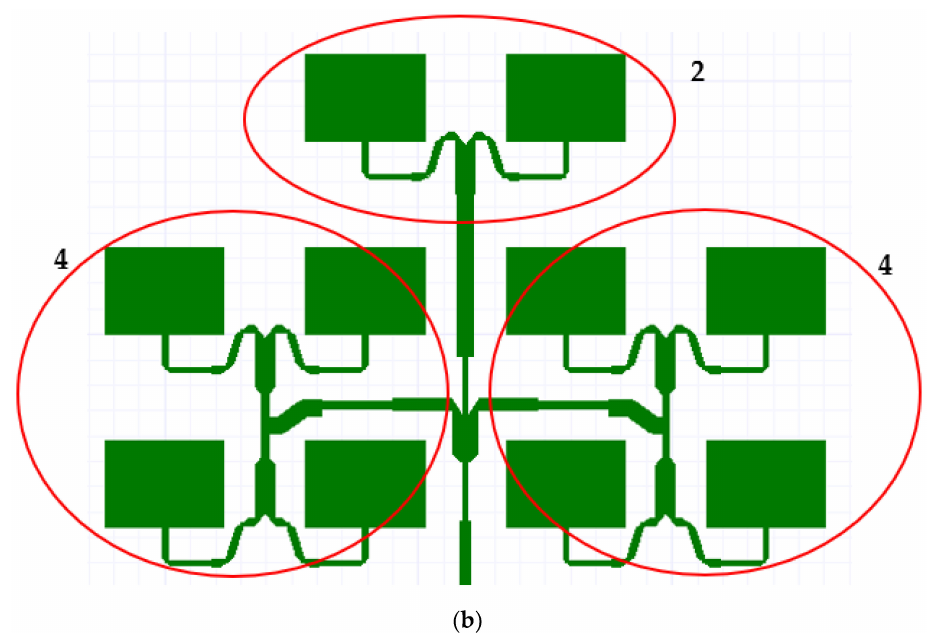
Figure 13. ( a ) Power division network from 1 to 4:2:4 power ratio, with ideal transmission lines. ( b ) Power division network from 1 to 4:2:4 power ratio. Microstrip radiators with microstrip trans- mission line transformers and the power values are indicated.